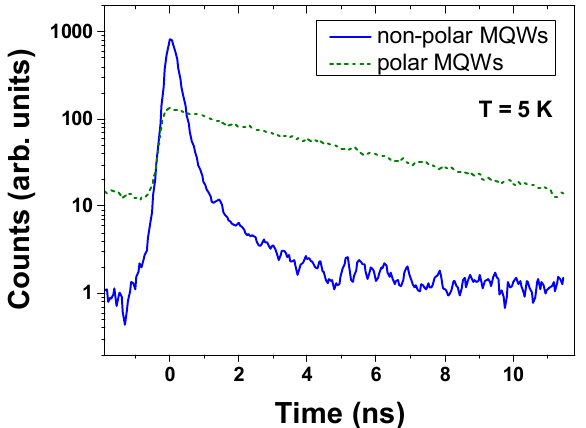
Figure 7. Low-temperature PL decay of non-polar (solid blue line) and polar (dashed green line) GaN/Al 0.26 Ga 0.74 N (3 nm/22.5 nm) MQW structures, measured at pulsed 300 nm-wavelength excitations.